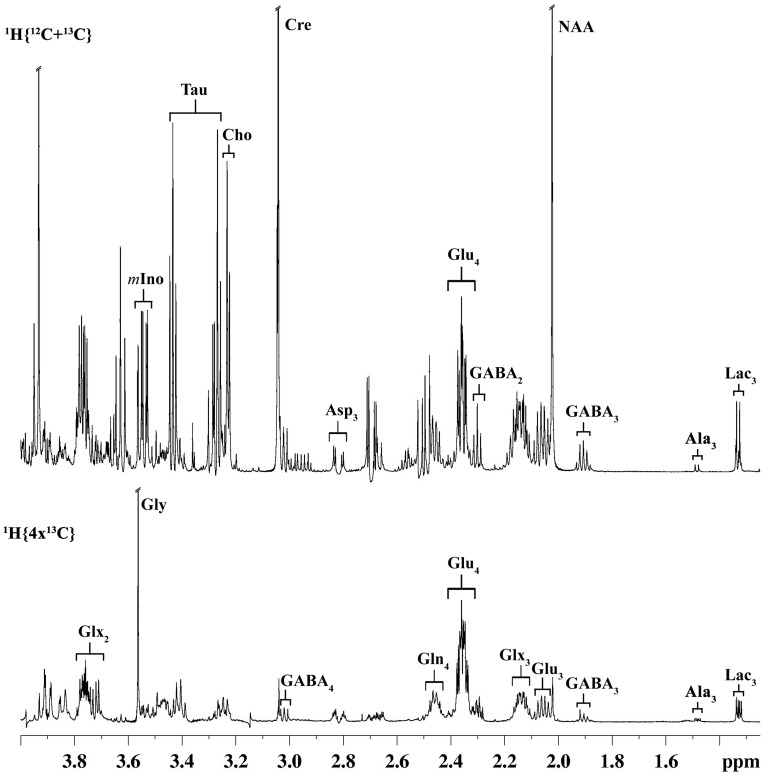
Representative 1H-[13C]-NMR spectrum of cortical tissue extract of nicotine-treated mouse.The upper spectrum (1H{12C+13C}) depicts total concentration of metabolites, while the lower spectrum (1H{4×13C}) represents the 13C labeled metabolites. Peak labels are: Ala3, alanine-C3; GABA, γ-amino butyric acid; Gln4, glutamine-C4; Glu4, glutamate-C4; Glu3, 0.5 × glutamate-C3; Glx3, (0.5 × glutamate + glutamine)-C3; Asp3, aspartate-C3; Cre, creatine; NAA, N-acetyl aspartate; Cho, choline, m-Ino, myo-inositol; Tau, taurine.